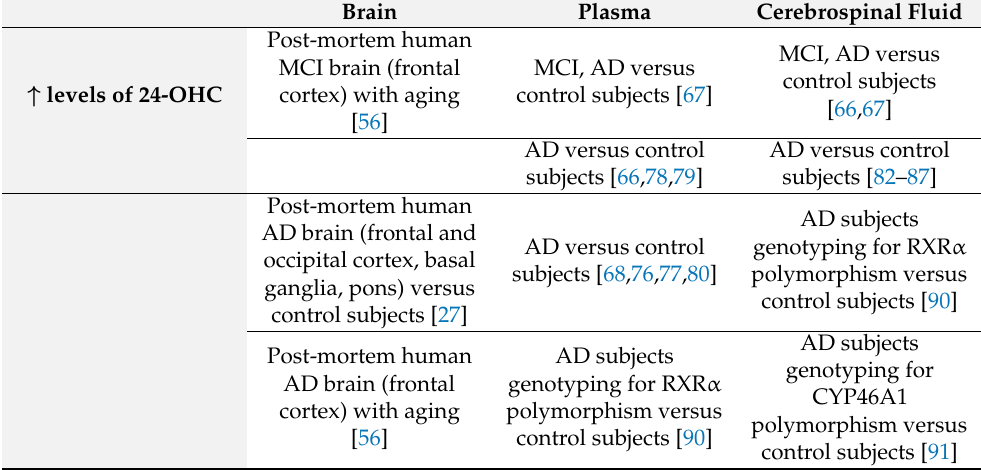
Table 1. Changes in 24-OHC levels in the brain, blood and cerebrospinal fluid of MCI or AD